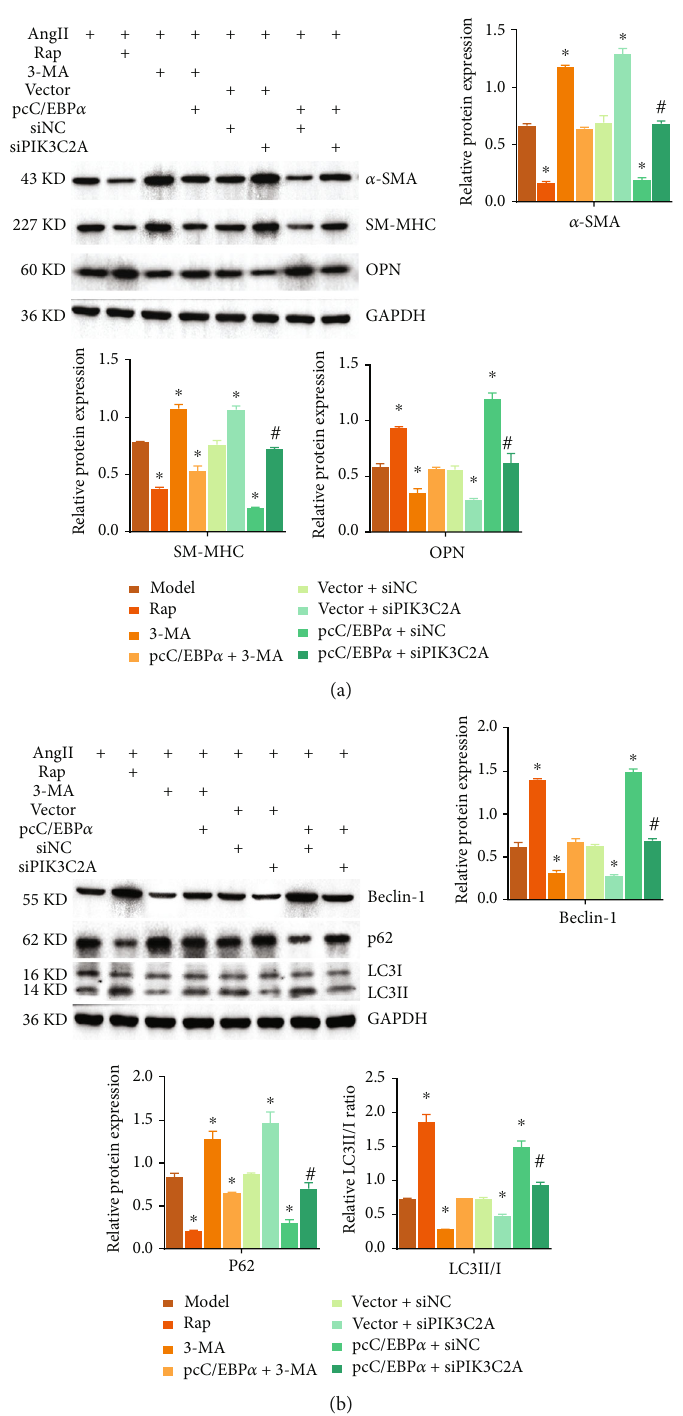
Figure 7: The impact of PIK3C2A and autophagy in angiotensin II- (Ang II-) treated VSMCs. The autophagy and phenotype changes in Ang II-treated VSMCs were analyzed by Western blot. GAPDH was used as an internal control. Data are presented as means ± SEM . (a) Evaluation of the in fl uence on the expression of α -SMA, SM-MHC, and OPN proteins. (b) Evaluation of the in fl uence on the expression of Beclin-1, p62, LC3II, and LC3I proteins. Model: treated with 1 μ M Ang II; Rap: cotreated with 1 μ M Ang II and 0.25 μ M rapamycin; 3-MA: cotreated with 1 μ M Ang II and 5mM 3-methyladenine; pcC/EBP α +3-MA: cotreated with 1 μ M Ang II and 5 mM 3- methyladenine in C/EBP α -overexpressed VSMCs; vector+siNC: treated with 1 μ M Ang II in pcDNA3.1 and siRNA NC cotransfected VSMCs; vector+siPIK3C2A: treated with 1 μ M Ang II in pcDNA3.1 and PIK3C2A siRNA cotransfected VSMCs; pcC/EBP α +siNC: treated with 1 μ M Ang II in pcC/EBP α and siRNA NC cotransfected VSMCs; pcC/EBP α +siPIK3C2A: treated with 1 μ M Ang II in pcC/ EBP α and PIK3C2A siRNA cotransfected VSMCs. ∗ P < 0 : 05 vs. model, # P < 0 : 05 vs. pcC/EBP α